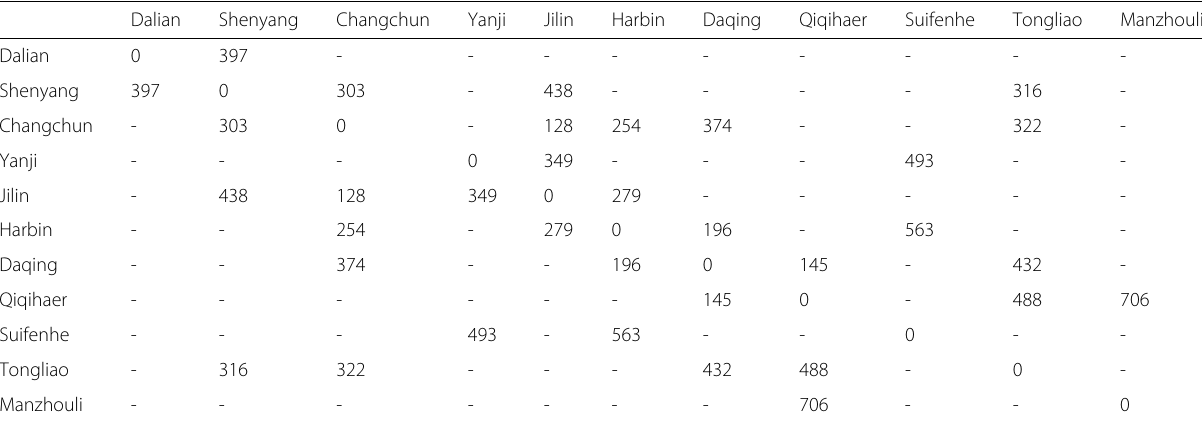
Table 4 Distance matrix of the network (km)